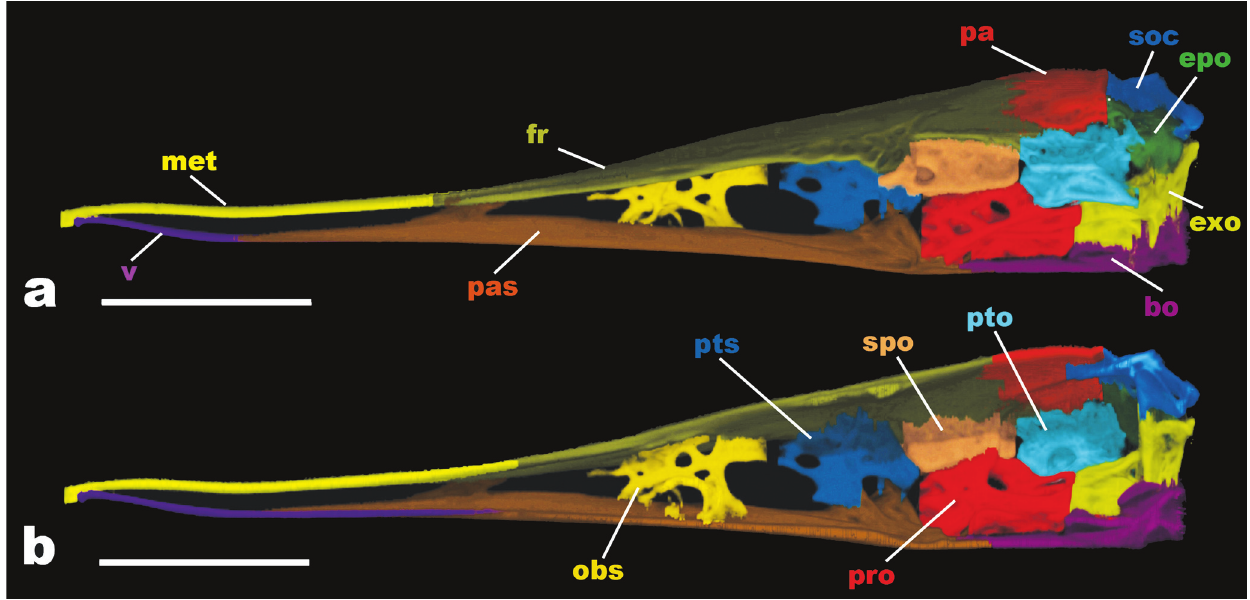
Fig. 4. Skull roof and brain case of the left side of Iracema caiana (MZUSP 49205, 235 mm SL). ( a ) Lateral view; ( b ) Midsagittal view. Anterior to left. Scale bar is 5 mm. Abbreviations: v = ventral ethmoid+vomer; met = mesethmoid; pas = parasphenoid; fr = frontals; obs = orbitosphenoid; pts = pterosphenoid; pro = prootic; spo = sphenotic; pto = pterotic; pa = parietal, bo = basioccipital; exo = exoccipital; epo = epioccipital; and soc = supraoccipital.